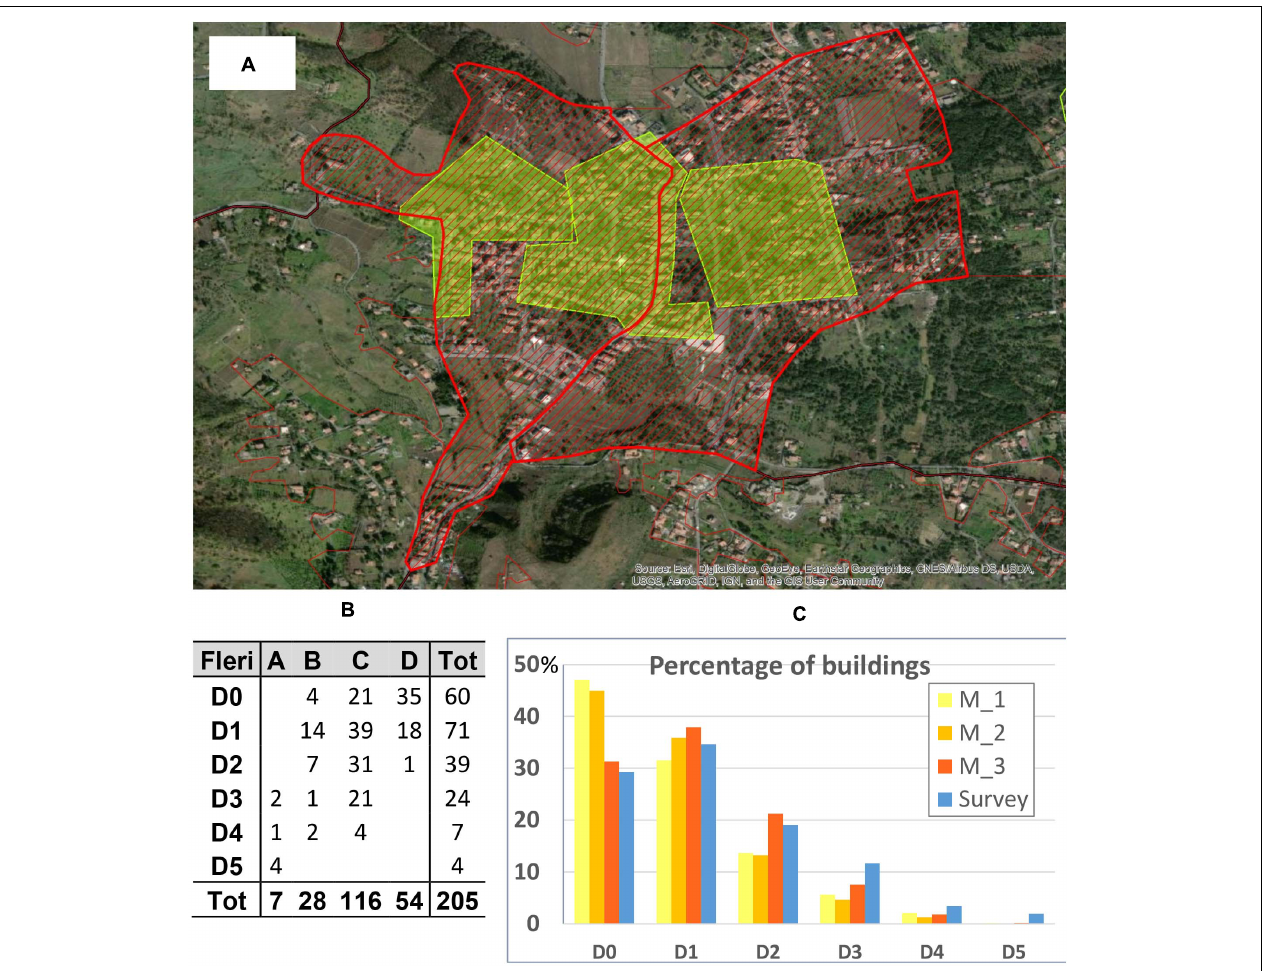
FIGURE 9 | Locality of Fleri: (A) coverage of the ISTAT census section (red polygons) and the surveyed areas (green polygons). (B) Number of surveyed building according to vulnerability (A ÷ D) and damage classes. (C) Comparison of damage estimation between the simulated distributions (M_1 ÷ M_3) and the one derived by the survey in the green